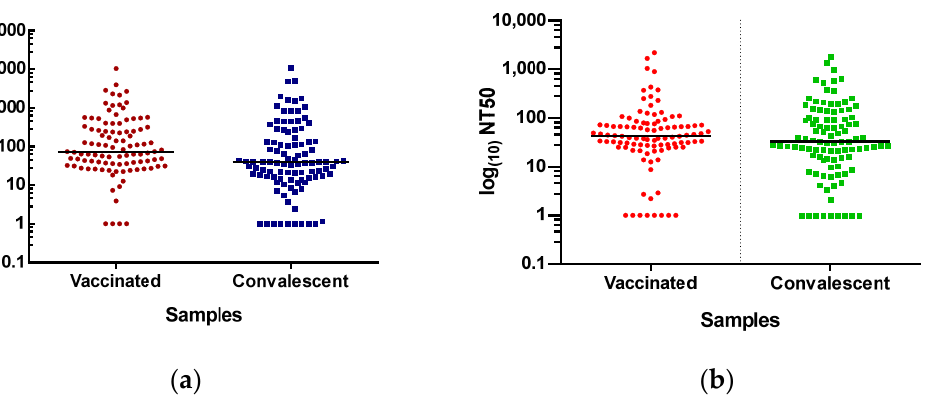
Figure 6. SARS-CoV-2-neutralising antibody titres obtained in the Sinopharm-vaccinated cohort and COVID-19-recovered patients. Scatter plot shows the results obtained ( a ) by HCI protocol and ( b ) by FC. The black line corresponds to the median. For visual purposes, 25 extreme values are not shown in the plot but are kept in the calculations. Healthy donor sera were tested at a single 1:12.5 dilution, and all showed an NT 50 < 0.94.